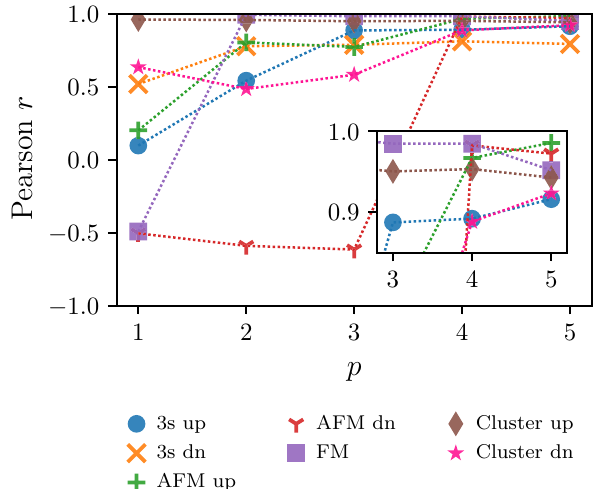
FIG. 9. Pearson correlation coefficients as a function of p for the data in Figs. 3, 6(c), and 7(c). Labels “up” and “dn” denote data above and below the critical line of the corresponding model, respectively. The inset shows an enlarged view of the top-right corner of the plot. 3s,